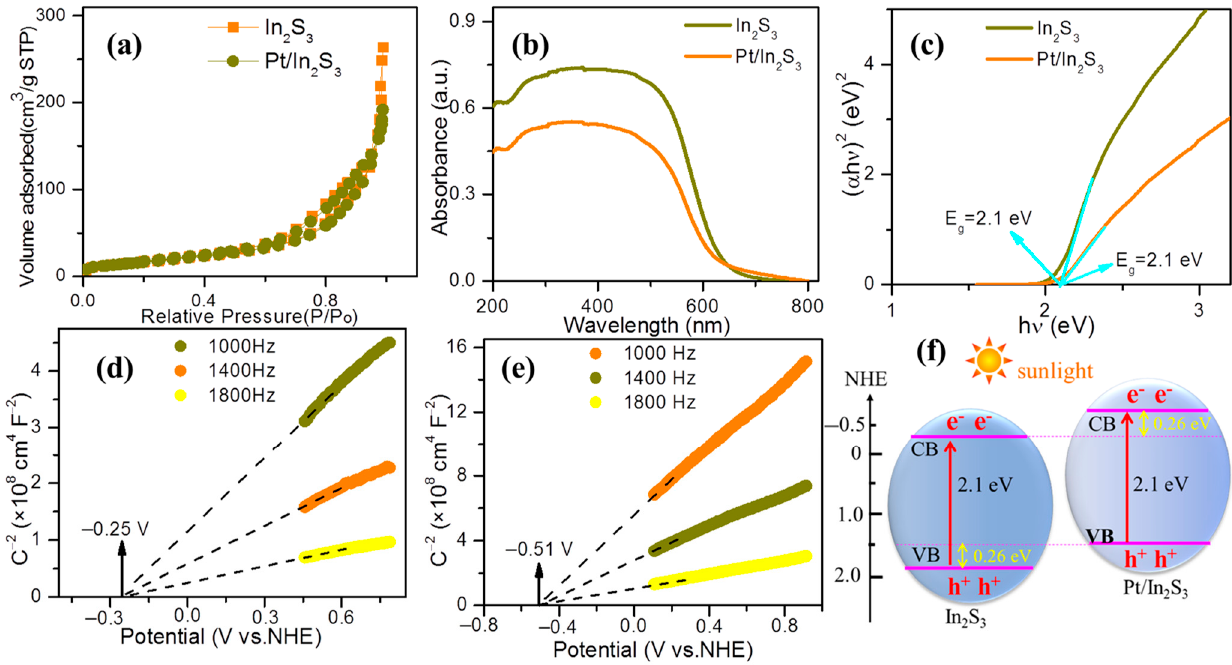
Figure 4. ( a ) Nitrogen adsorption–desorption isotherms, ( b ) UV-vis DRS spectra and ( c ) band-gap energies of In 2 S 3 and Pt/In 2 S 3 . M-S plots of ( d ) In 2 S 3 and ( e ) Pt/In 2 S 3 . ( f ) The relationships of band energy positions between In 2 S 3 and Pt/In 2 S 3 .